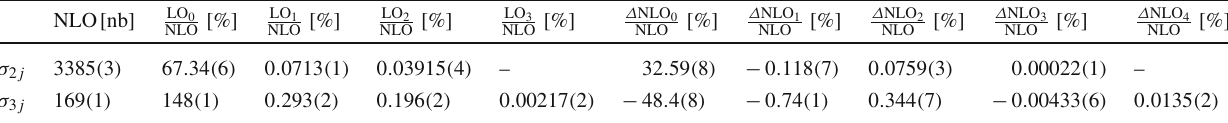
Table 1 Full NLO fiducial cross section for two- and three-jet production in the phase space detailed in the text, i.e. p T ( j 1 ) > 80 GeV and p T ( j i ) > 60 GeV ( i > 1). Besides the total cross section the relative contributions for the terms specified in Eq. (4) are given